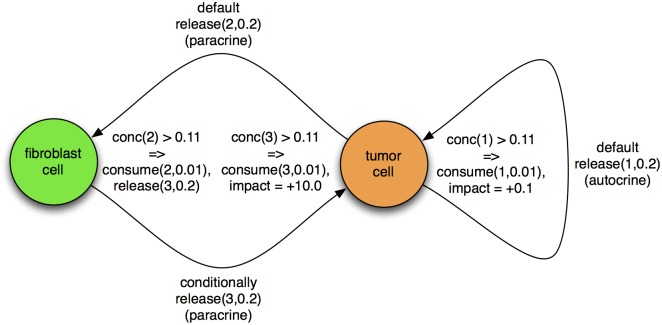
Tumor-stroma signaling.A schematic view of the tumor-stroma signaling described below, and quantified in Tables 10–19.